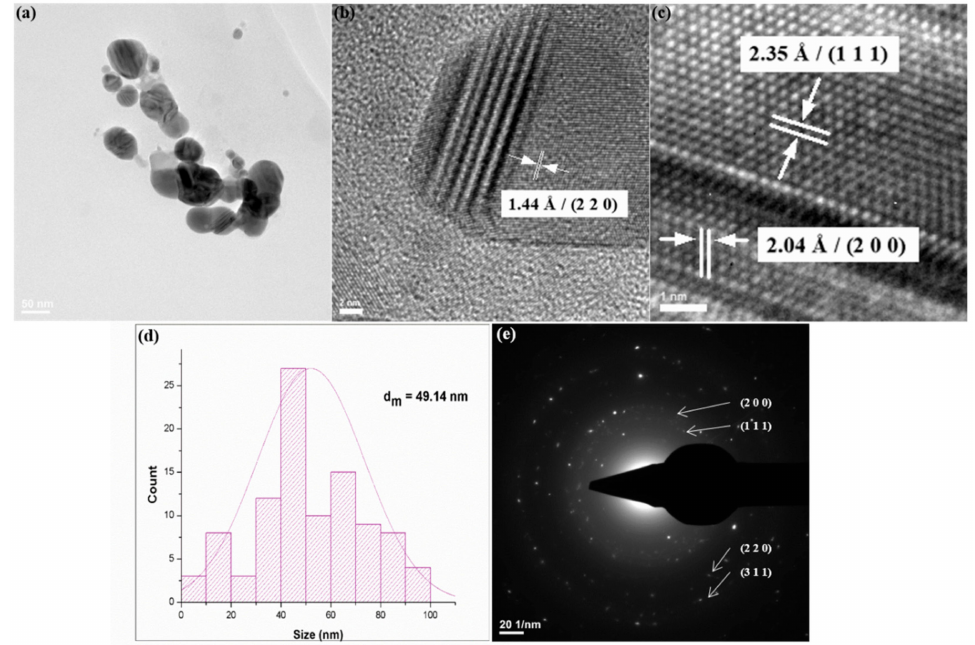
Figure 2. TEM micrograph ( a ), HR-TEM images ( b , c ), particle size histogram ( d ) and SAED pattern ( e ) of AgNPs.